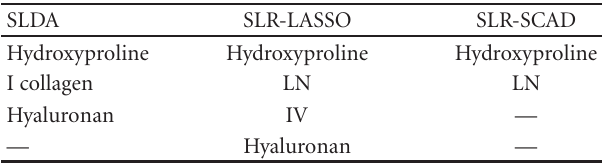
Table 5: List of variable selection results. SLDA